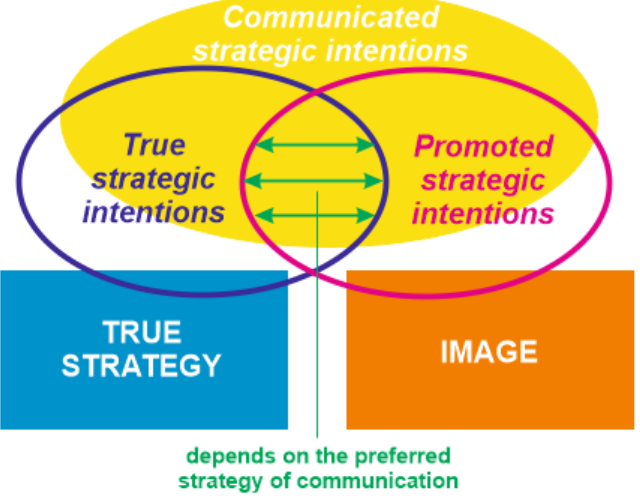
Figure 5. Schematic representation of the intentions communicated via web positioning.